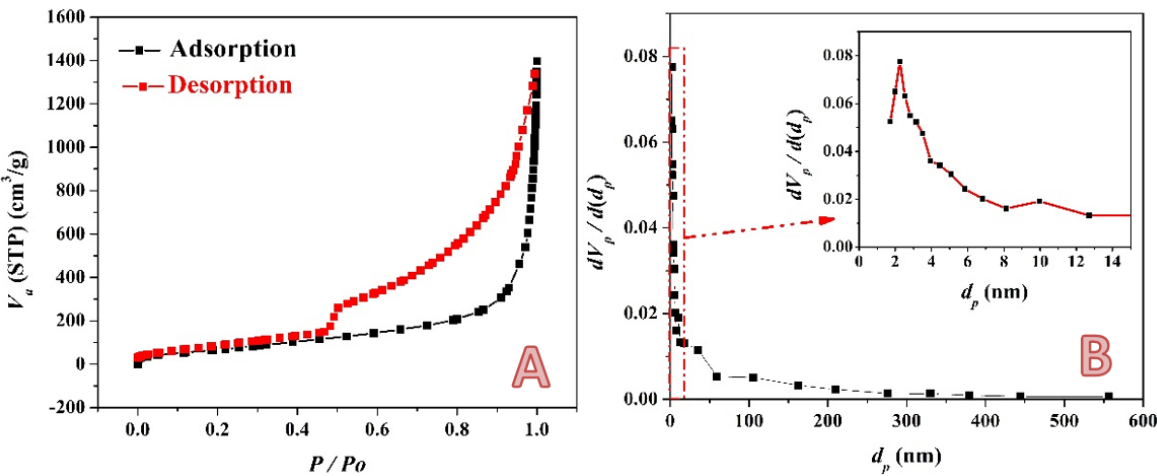
Figure 6. Nitrogen adsorption/desorption isotherm; ( A ) and pore size distribution curve; ( B ) for the